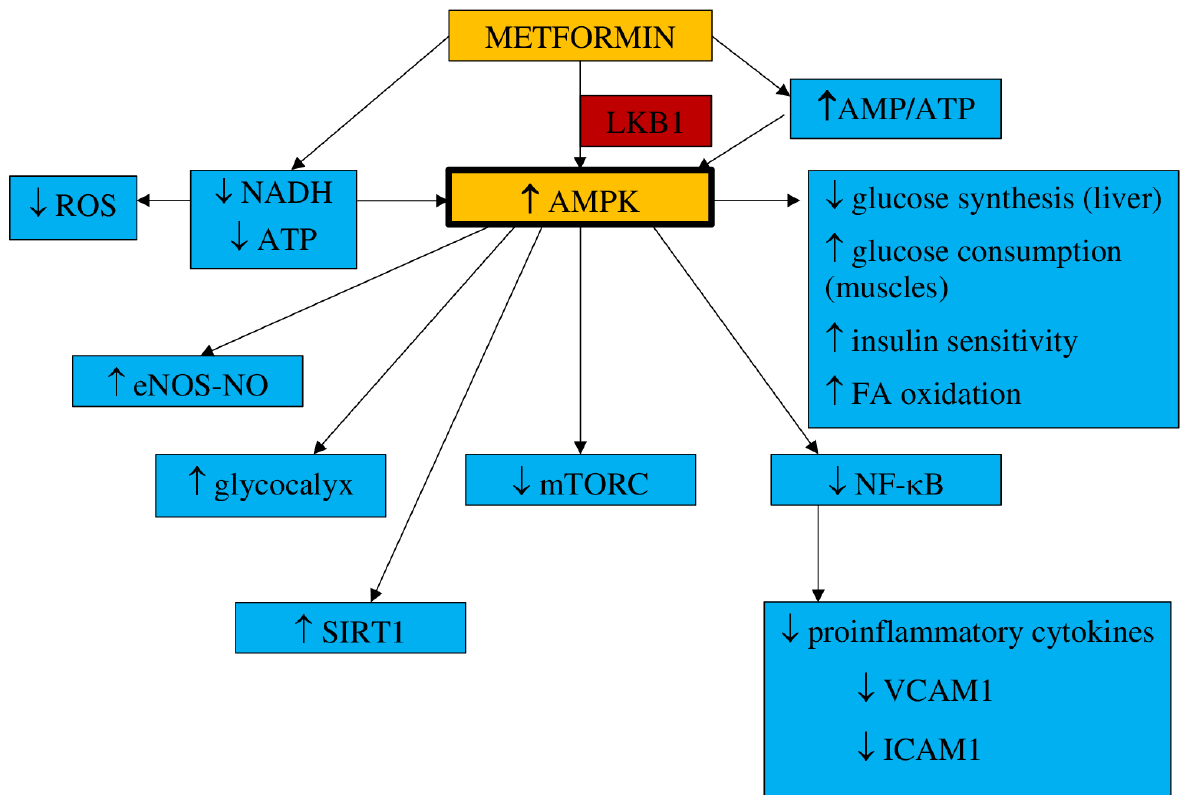
Figure 1. Main mechanisms of metformin action. AMPK—5′-adenosine monophosphate-activated protein kinase, AMP—5′-adenosine monophosphate, ATP—adenosine triphosphate, LKB1—liver kinase B1, NADH—nicotinamide adenine dinucleotide, ROS—reactive oxygen species, eNOS—endothelial nitric oxide synthase, NO—nitric oxide, SIRT1—sirtuin 1, mTORC—mammalian target of rapamycin, FA—fatty acids, NF-κB—nuclear factor kappa B, VCAM1—vascular cell adhesion molecule 1, ICAM1—intracellular adhesion molecule 1, MCP1—monocyte chemoattractant protein 1.